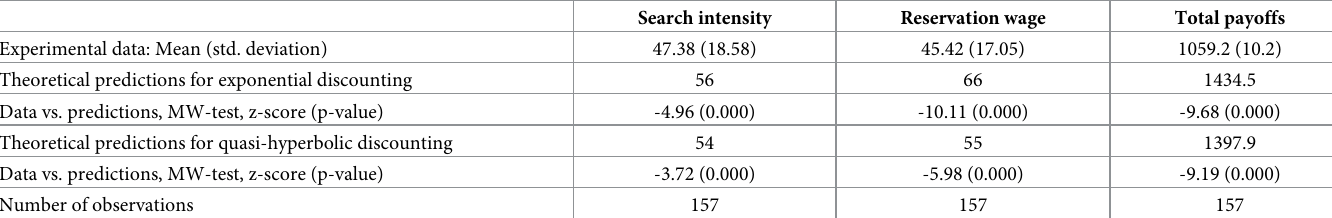
Table 1. Experimental data vs. theoretical